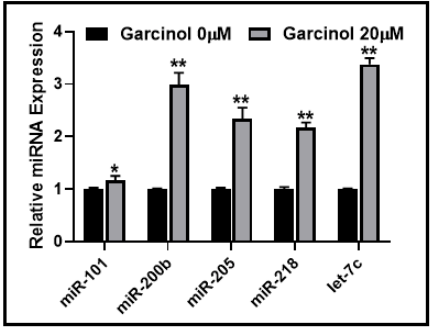
Figure 4. Garcinol upregulates EMT-regulating miRNAs. A549M cells were treated with 20 µ M garcinol for 72 h and the expression of select miRNAs was evaluated relative to control cells (garcinol 0 µ M). * p < 0.05, ** p < 0.01.